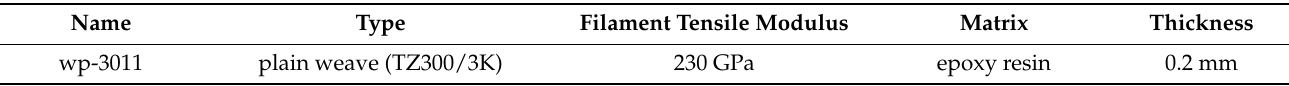
Table 2. The parameters of test material [49].